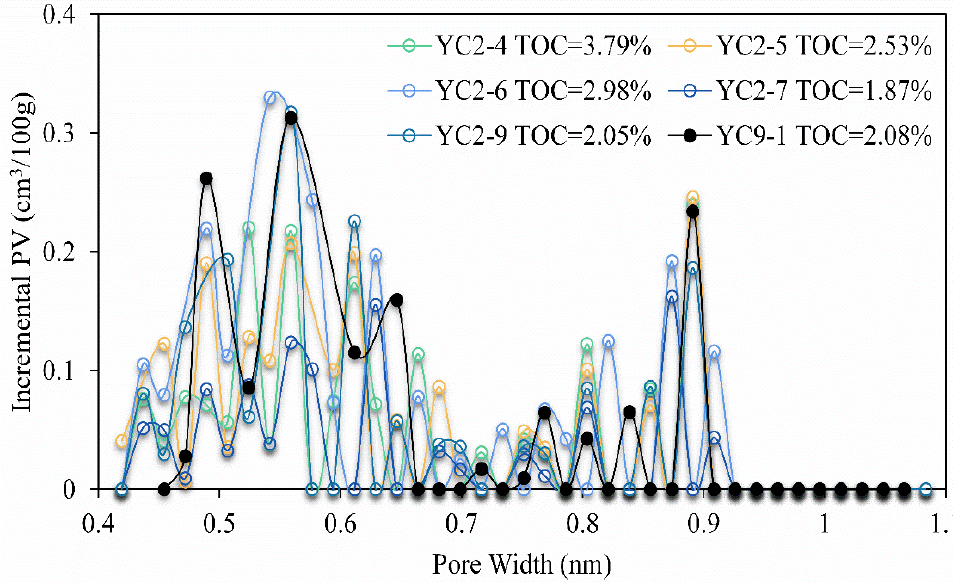
Figure 10. PSD curves of the selected samples with different TOC based on their LPCA data. The YC2 samples and the sample YC9-1 have no significant difference, and both show multi-peaks.